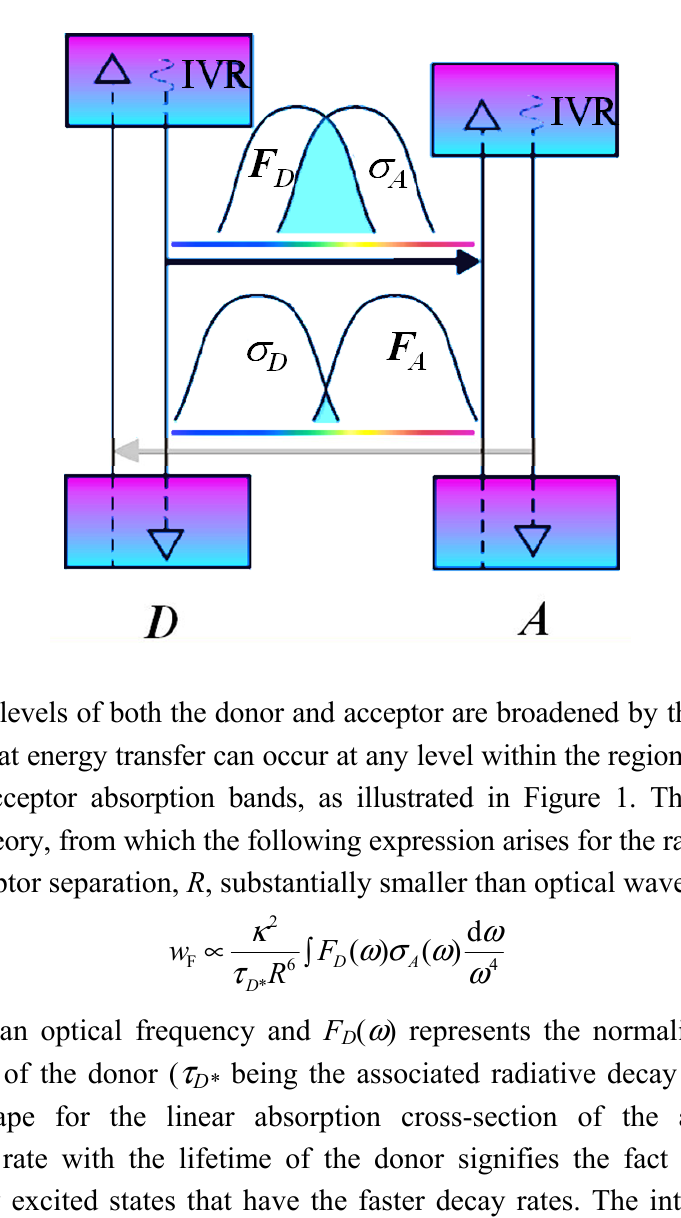
Figure 1. Energetics for pair-wise RET and associated spectral overlaps: (top) transfer from D to A ; (below) potential backward transfer, A to D : F —fluorescence spectrum; σ —absorption spectrum; IVR—intramolecular vibrational